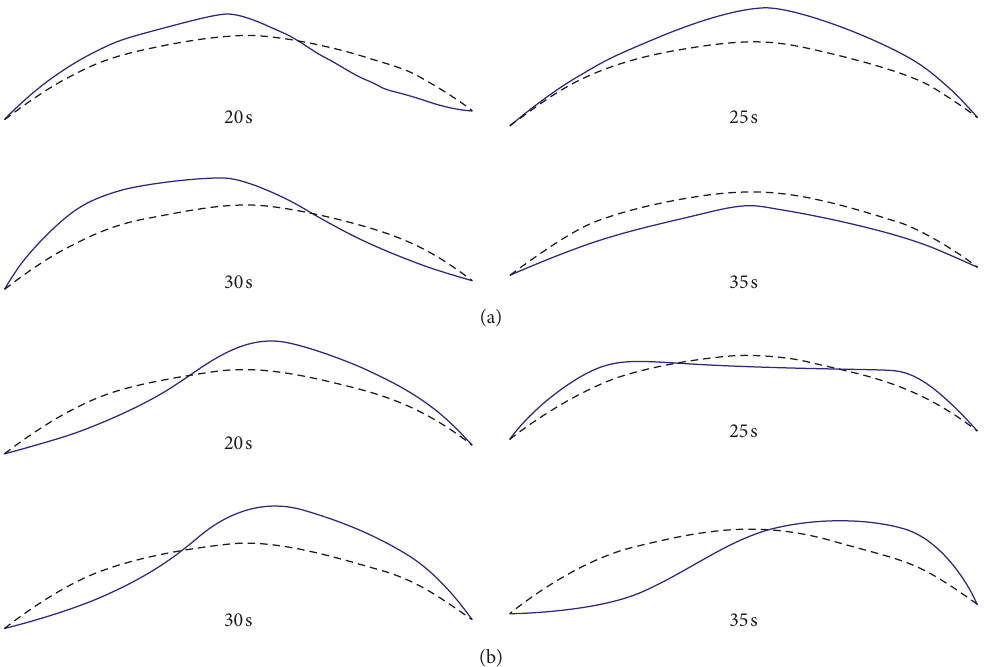
Figure 20: Time-varying modal shape vectors of the Pacoima dam using the strong-motion records of the Newhall earthquake (dash line represents the original arch circle, and blue line represents the modal shape): (a) mode 1; (b) mode